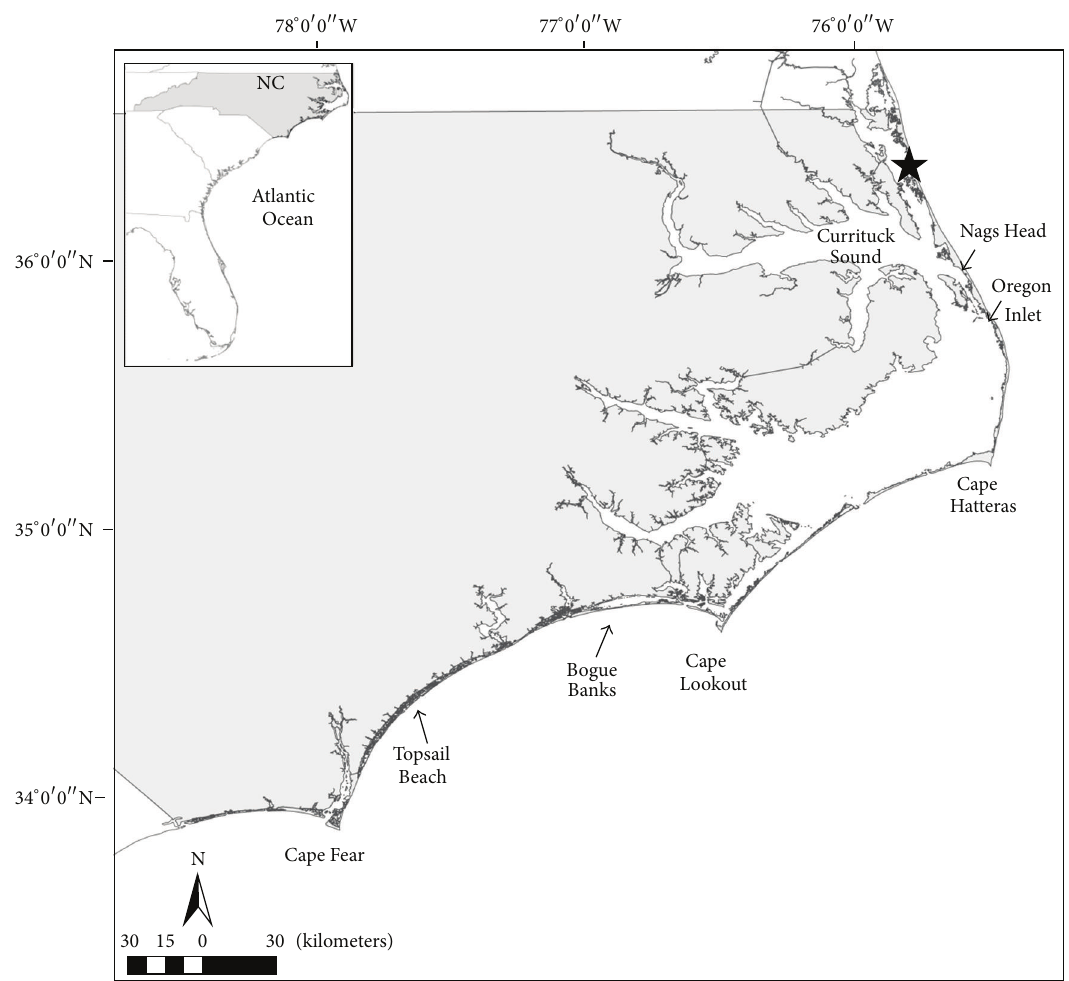
Figure 1: Coastal North Carolina. The barrier islands east of the island Bogue Banks north to the Virginia border are called the Outer Banks. The star corresponds to the end of Highway 12, after which access to the area to the north is by beach